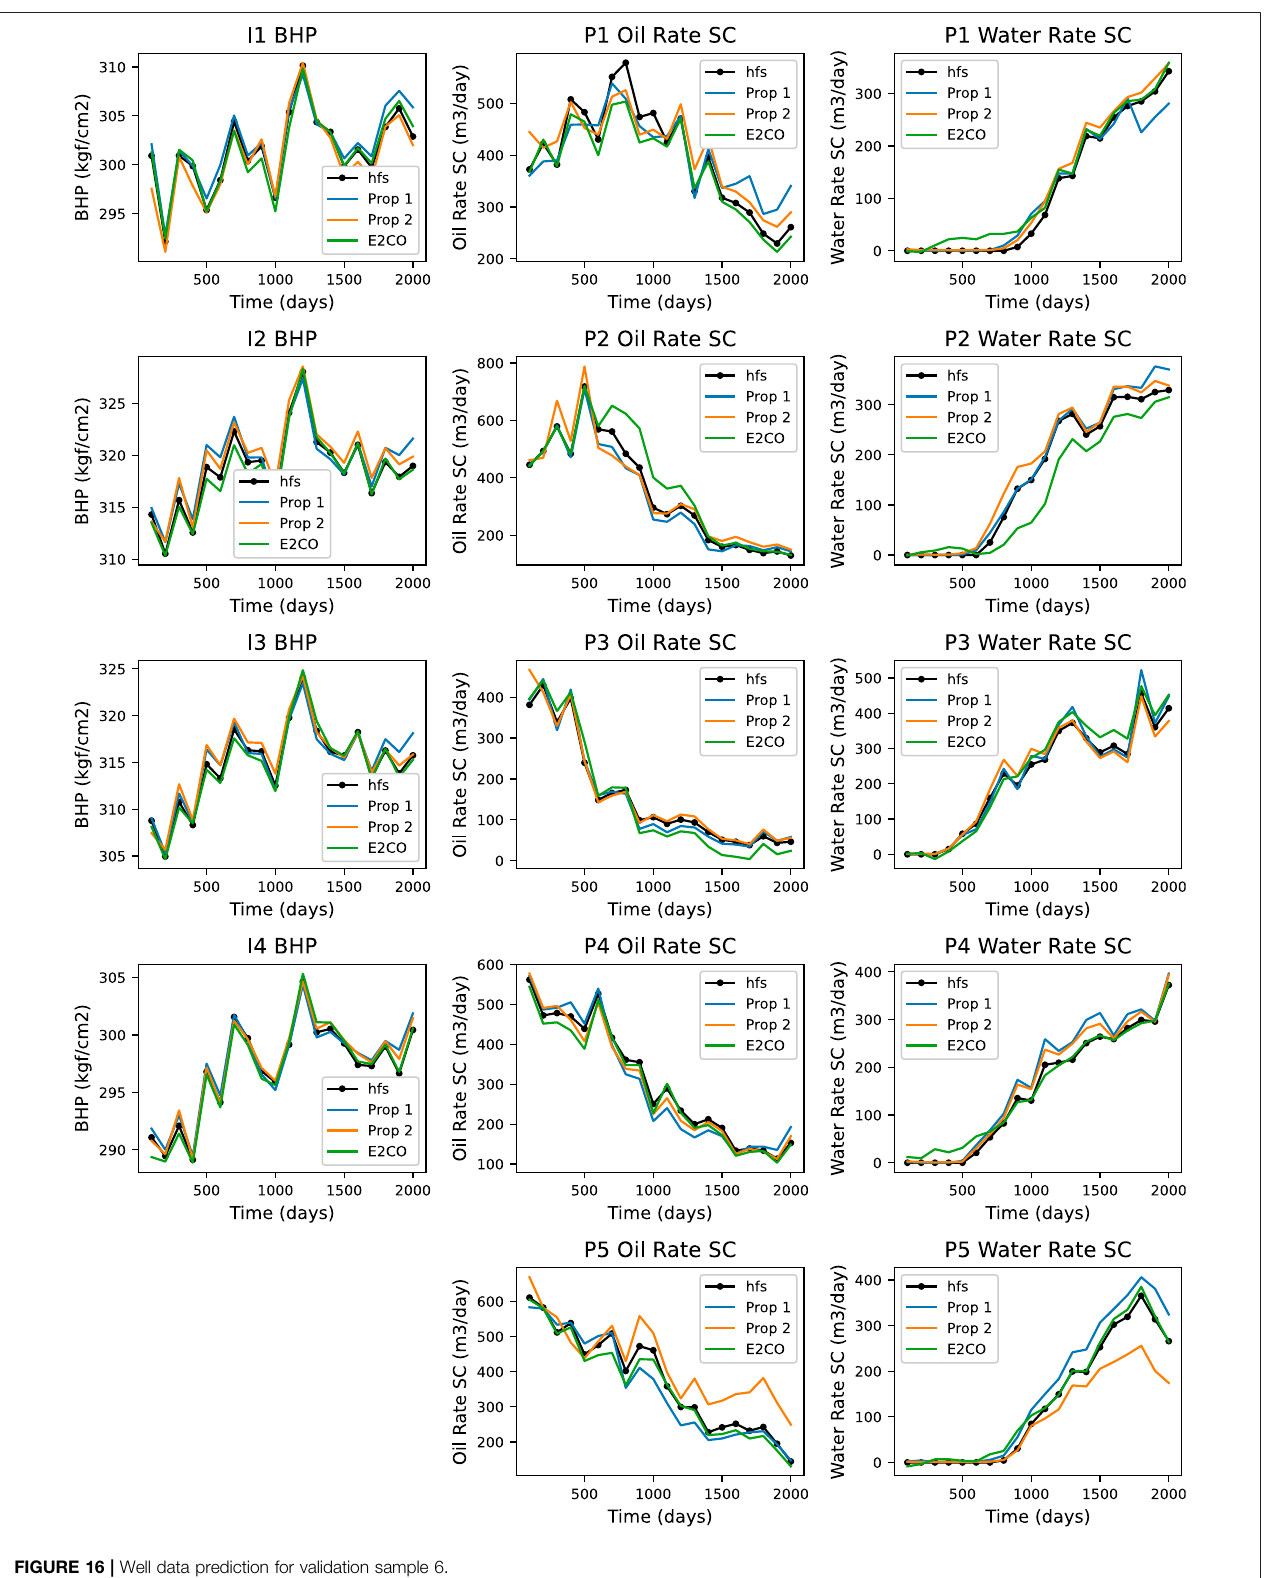
FIGURE 16 | Well data prediction for validation sample 6.